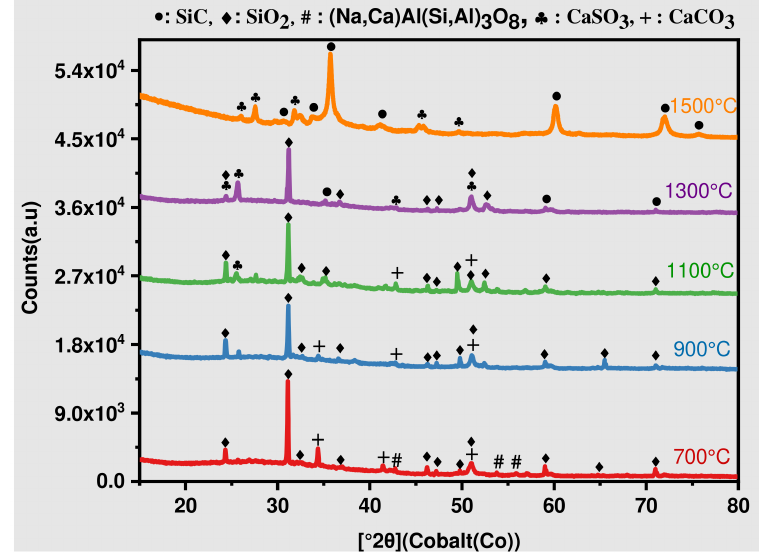
Figure 5. XRD spectrums of heat-treated mixed ASR plastics and glass at 700 ◦ C to 1500 ◦ C for 2 h (Adapted from Hemati, et al.